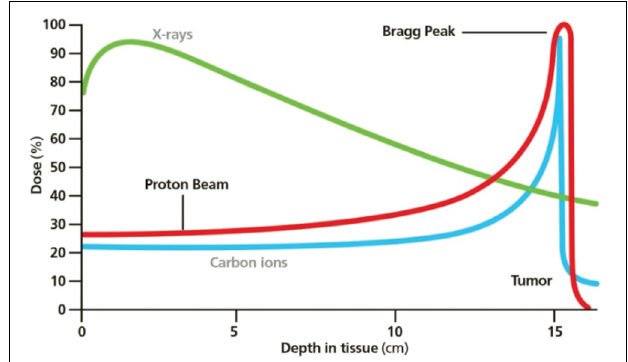
FIGURE 2 | Bragg peak in PBT. Reprinted from Mustapha et al. (81) with the permission of AIP Publishing.